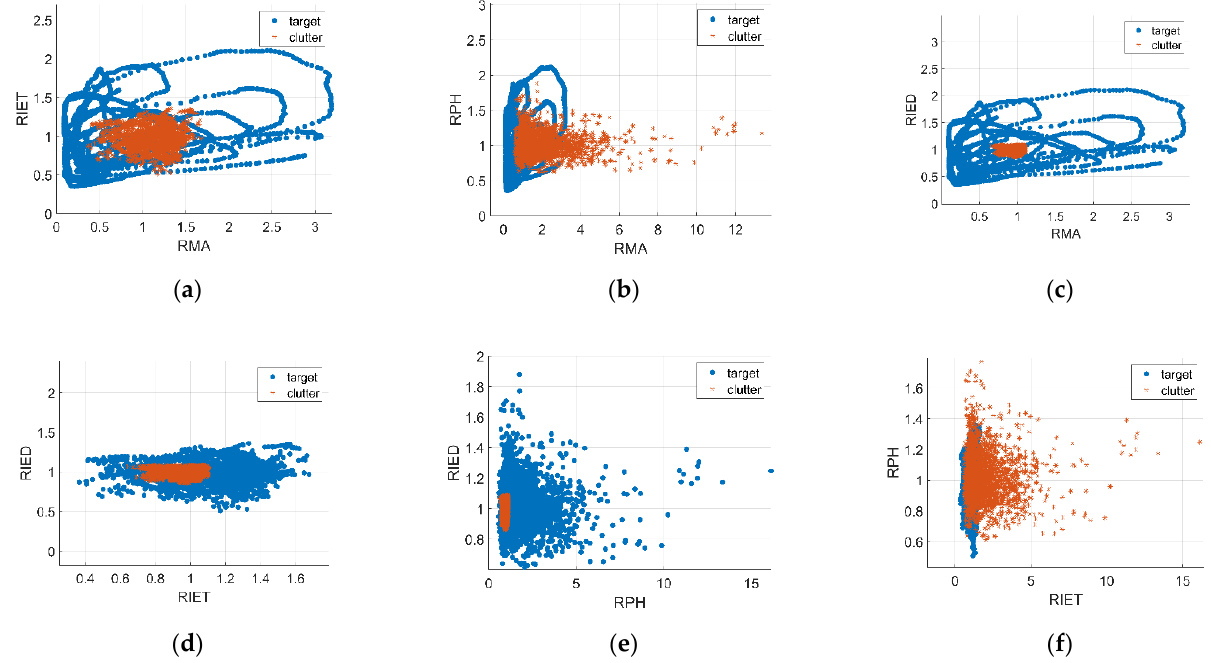
Figure 11. Representation of two-dimensional characteristics on targets and clutter. ( a ) RMA—RIET; ( b ) RMA—RPH; ( c ) RMA—RIED; ( d ) RIET—RIED; ( e ) RPH—RIED; ( f ) RIET—RPH.